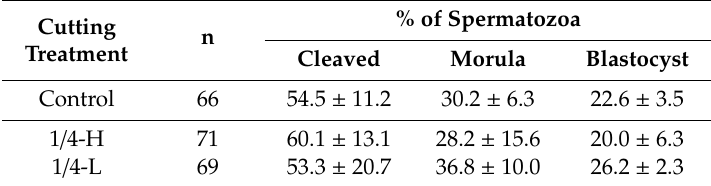
Table 3. The effects of ultrasonic cutting treatment on the developmental competence of spermatozoa. Cutting % of Spermatozoa n Treatment Cleaved Morula Blastocyst Control